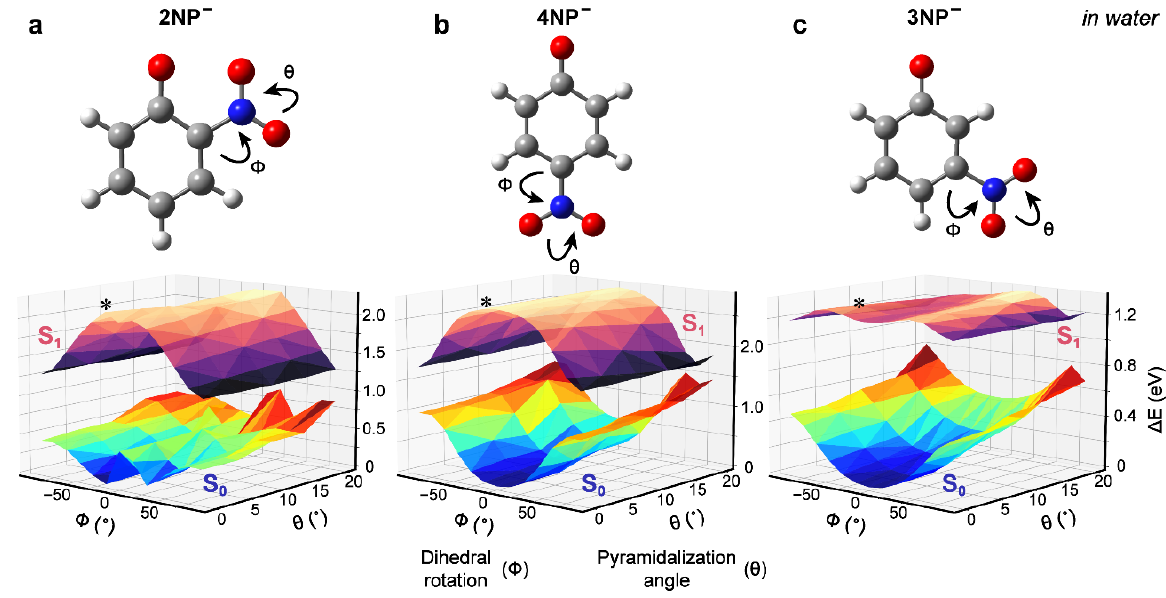
Figure 4. 2D-coordinate scans of S 1 and S 0 energies for the nitrophenolates along the nitroaromatic dihedral angle and pyramidalization angle in water. The two types of nuclear motion are depicted by curved arrows for ( a ) 2NP − , ( b ) 4NP − , and ( c ) 3NP − , with the potential energy surfaces (PESs) depicted below each chemical structure. The current figure perspectives are selected to illustrate the calculated multidimensional PESs (essentially displaying a 3D picture in 2D space) and focus on the comparative similarities and differences between three regioisomers of nitrophenolates in water. Details of the calculation are shown in the Methods section below. At each point, all other coordi- nates were relaxed in the S 1 state according to the TD-DFT optimization using the B3LYP level of theory, 6-31G+(d,p) basis sets, and the IEFPCM water solvent (default method for implicit solvent in Gaussian software [44]). Energies are shown in electron volts (eV) relative to the lowest-energy S 0 geometry. The Franck–Condon region accessed by vertical excitation from the optimized ground- state geometry is denoted by an asterisk (*) in each panel.